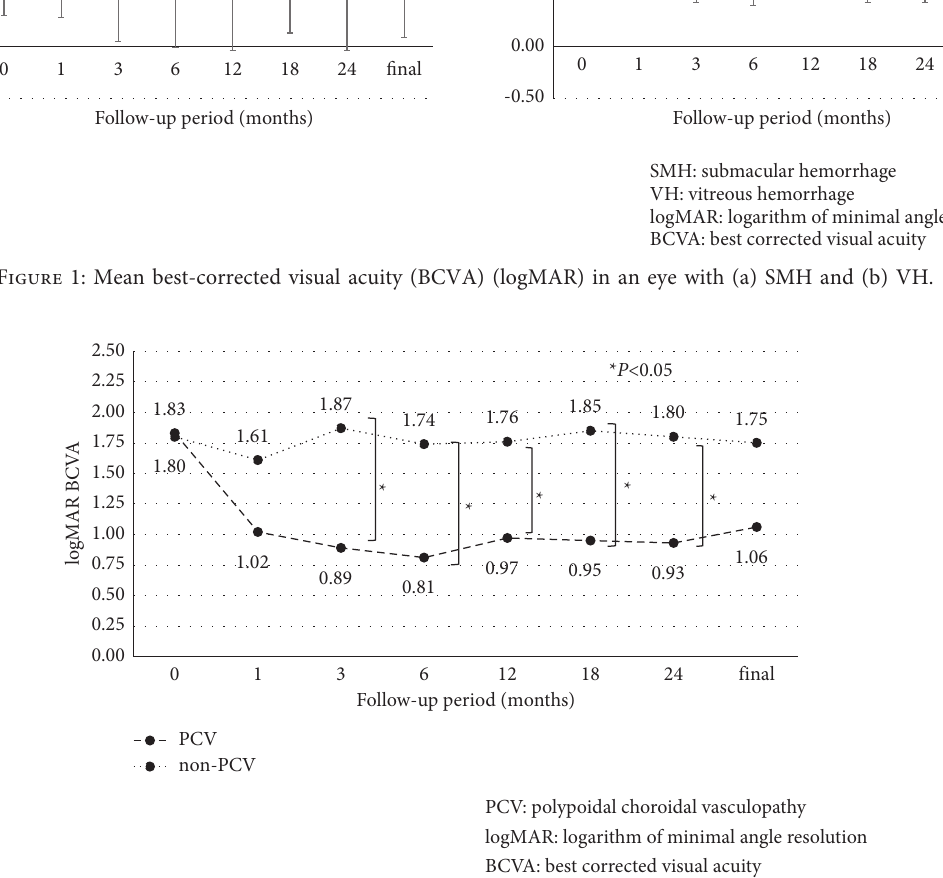
Figure 2: A comparison of best-corrected visual acuity (BCVA) between PCV and non-PCV in eyes with